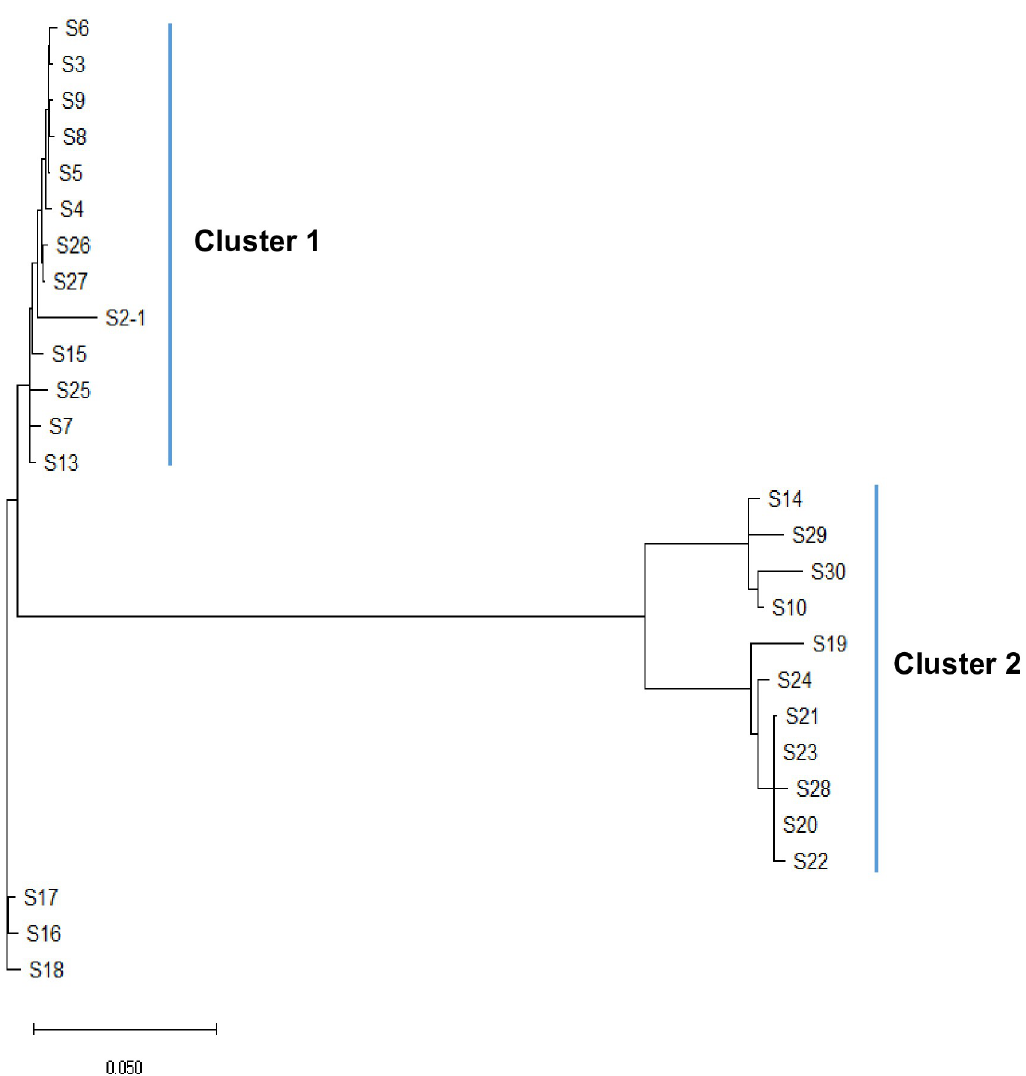
Fig 2. Phylogenetic trees of 27 A . baumannii according to single nucleotide polymorphism (SNP) analysis. Results of the phylogenetic tree using SNP analysis showed two major clusters.